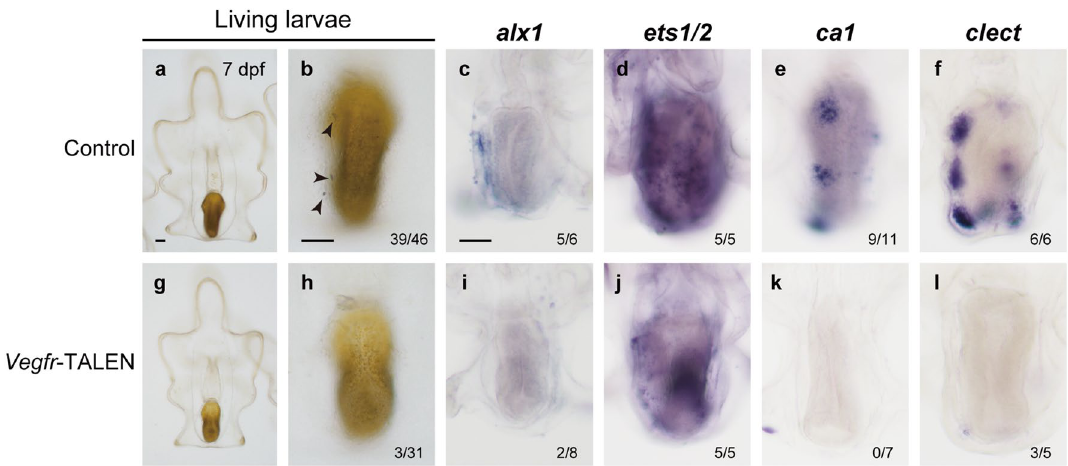
Figure 5. Morphology and gene expression in TALEN-mediated vegfr knockout starfish larvae. Adult skeleton formation and the expression of alx1 , ca1 , and clect were examined in control ( a – f ) and vegfr knockout larvae ( g – l ). In the panel b, arrowheads indicate adult skeletal rudiments. In panels b and h, the number in the lower right corner shows the number of larvae with skeleton rudiments/the total number of larvae examined. In the WMISH images ( c – f , i – l ), the number in the lower right corner shows the number of larvae with a positive WMISH signal/the total number of larvae examined. Scale bars: 50